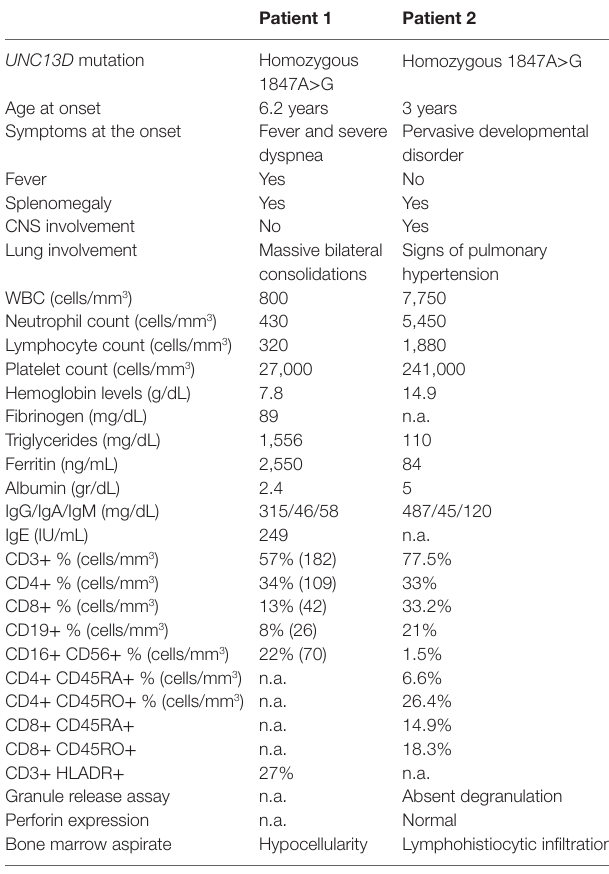
taBLe 1 | Comparison of clinical and laboratory markers in the two twins carrying the same UNC13D